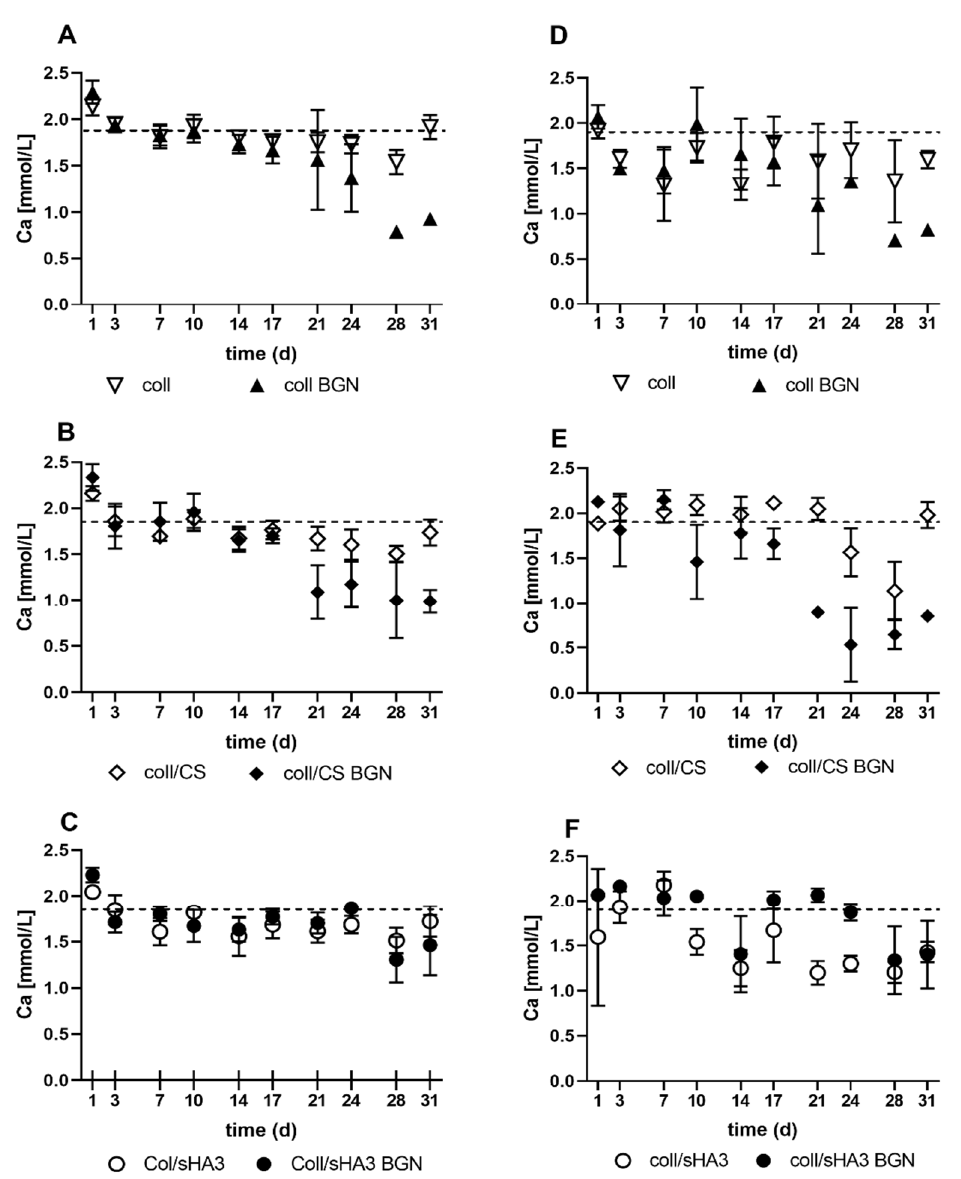
Figure 2. Calcium release from aECM: The calcium concentration was determined from supernatants of aECM incubated over 31 days at 37 °C in DMEM medium including 10% FCS and osteogenic supplements. Four different samples were analyzed per group and time point. ( A – C ): Calcium concentration as quantified by colorimetric analysis, ( D – F ) calcium content as quantified by ICP OES (see experimental section for further details). The dotted line represents the calcium concentration in the medium.